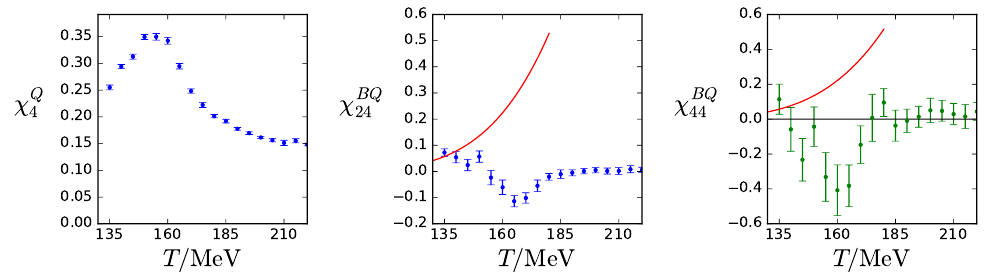
Figure 14 . (cid:31) Q ; (cid:31) BQ and estimate for (cid:31) BQ as functions of the temperature. The quantity (cid:31) Q 4 24 44 severe cut-o(cid:11) e(cid:11)ects on this lattice [28]. The red curves are the HRG model